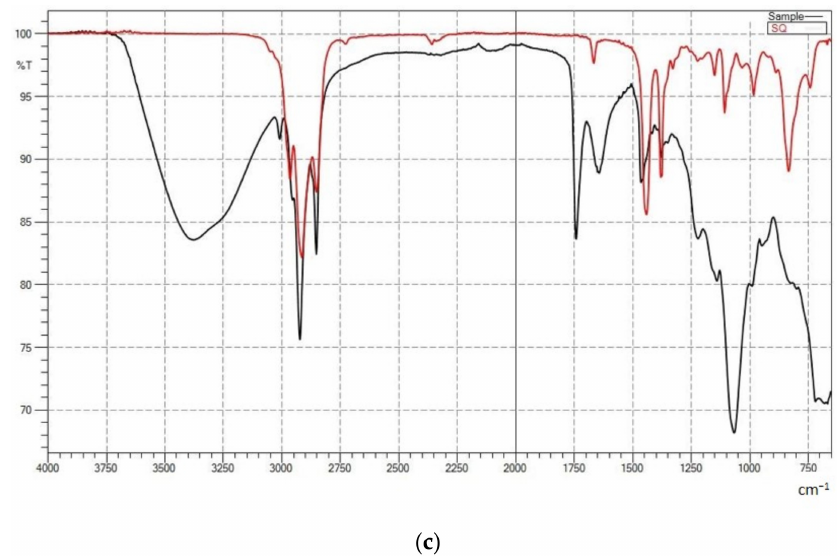
Figure 3. FTIR spectra showing ( a ) SQ-loaded liposome (5% ( w / w ) mixed soy lecithin (ML), 0.5% ( w / w ) squalene (SQ), 0.3% ( w / w ) cholesterol (CH) and 0.75% ( w / w ) Tween80 (TW80)), ( b ) overlap spectra of squalene (SQ)-loaded (black) and squalene (SQ)-free liposomes (5% ( w / w ) mixed soy lecithin (ML), 0.3% ( w / w ) cholesterol (CH) and 0.75% ( w / w ) Tween80 (TW80)) (red) and ( c ) overlap spectra of pure SQ (red) and SQ-loaded liposome